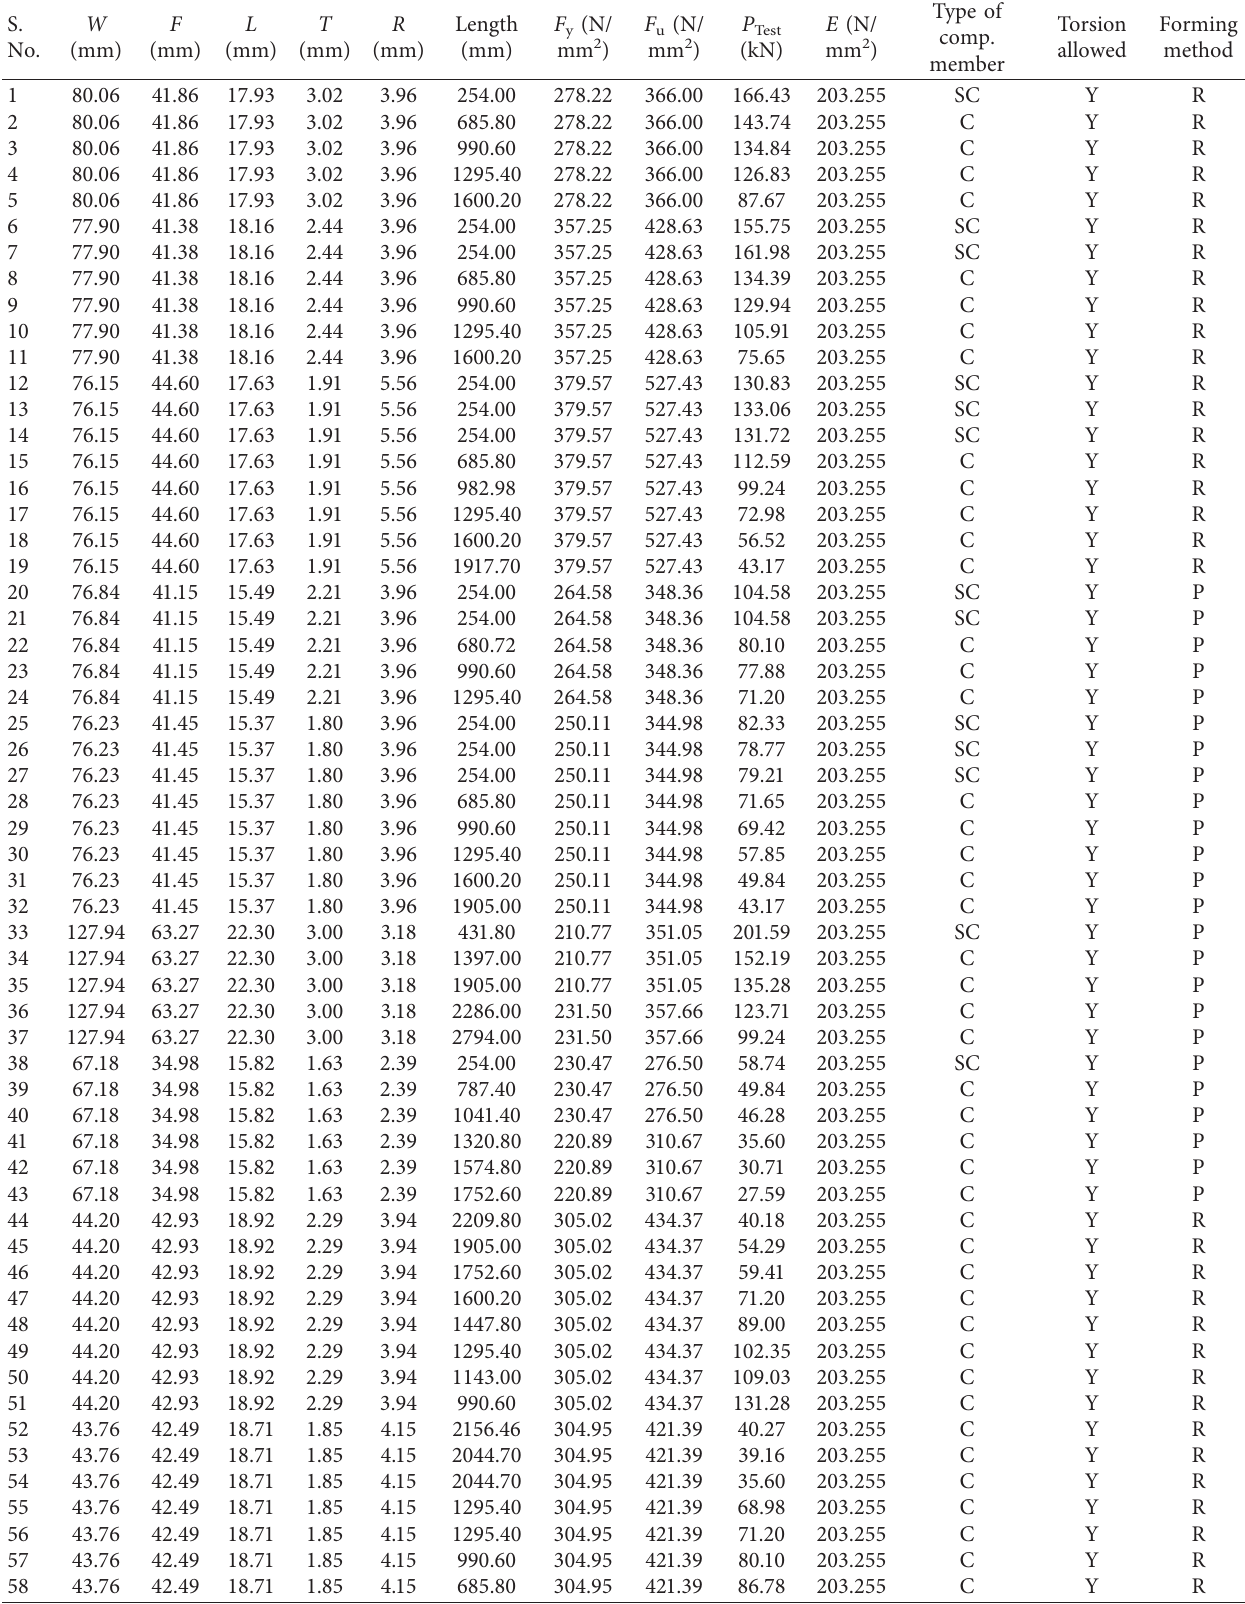
Table 4: Test database of axially loaded cold-formed steel lipped channel section compression